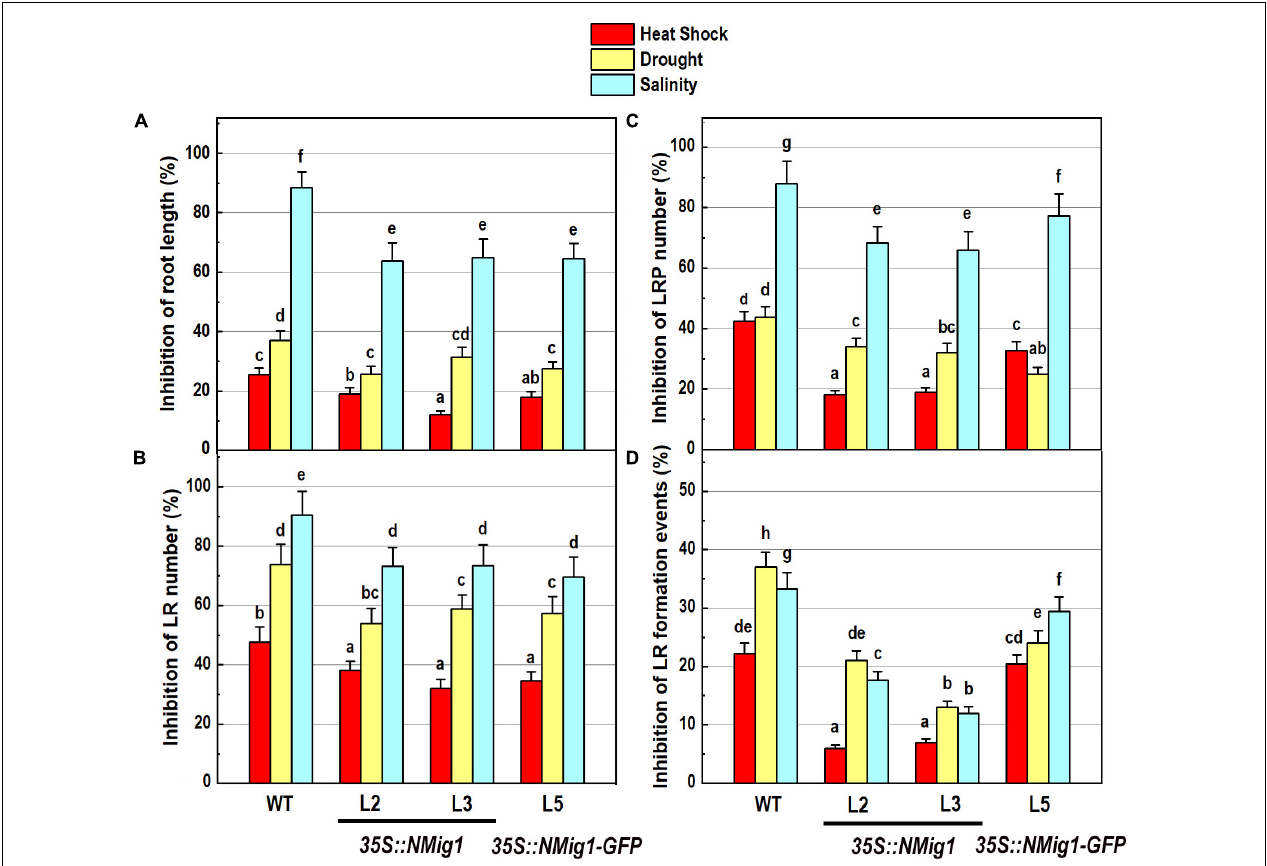
FIGURE 5 | Inhibitory effect of various abiotic stress factors (heat shock, drought and salinity) on primary root length and lateral root development of 10-day-old wild-type seedlings and transgenic lines overexpressing NMig1 (L2, L3, and L5): (A) inhibition of the primary root length, (B) inhibition of the number of lateral roots, (C) inhibition of the number of lateral root primordia, and (D) inhibition of the density of lateral root formation events. Different lowercase letters indicate statistically significant difference ( p ≤